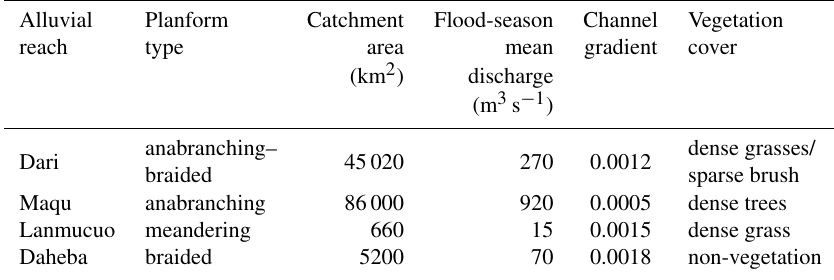
Table 1. Characteristics of the four study reaches (flood season is June–September). Alluvial Planform Catchment Flood-season Channel Vegetation reach type area mean gradient cover (km 2 ) discharge (m 3 s − 1 ) anabranching– dense grasses/ Dari 45020 270 0.0012 braided sparse brush Maqu anabranching 86000 920 0.0005 dense trees Lanmucuo meandering 660 15 0.0015 dense grass Daheba braided 5200 70 0.0018